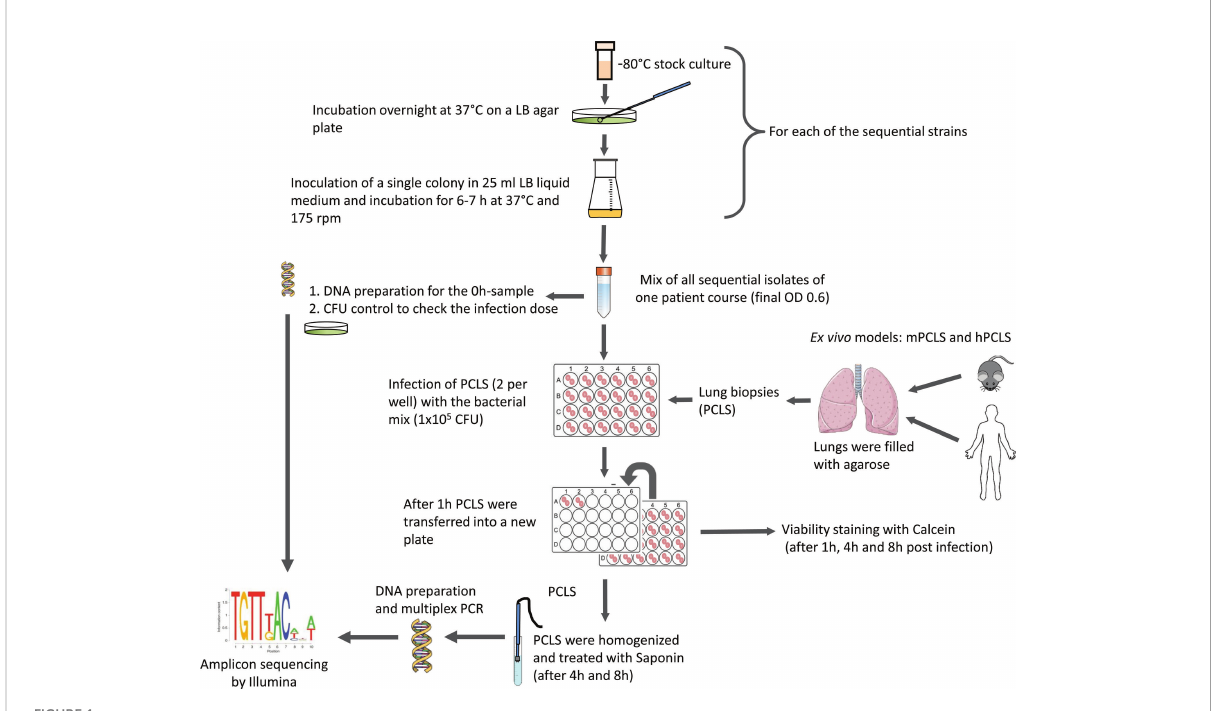
FIGURE 1 Outline of the competitive fi tness experiments in murine and human